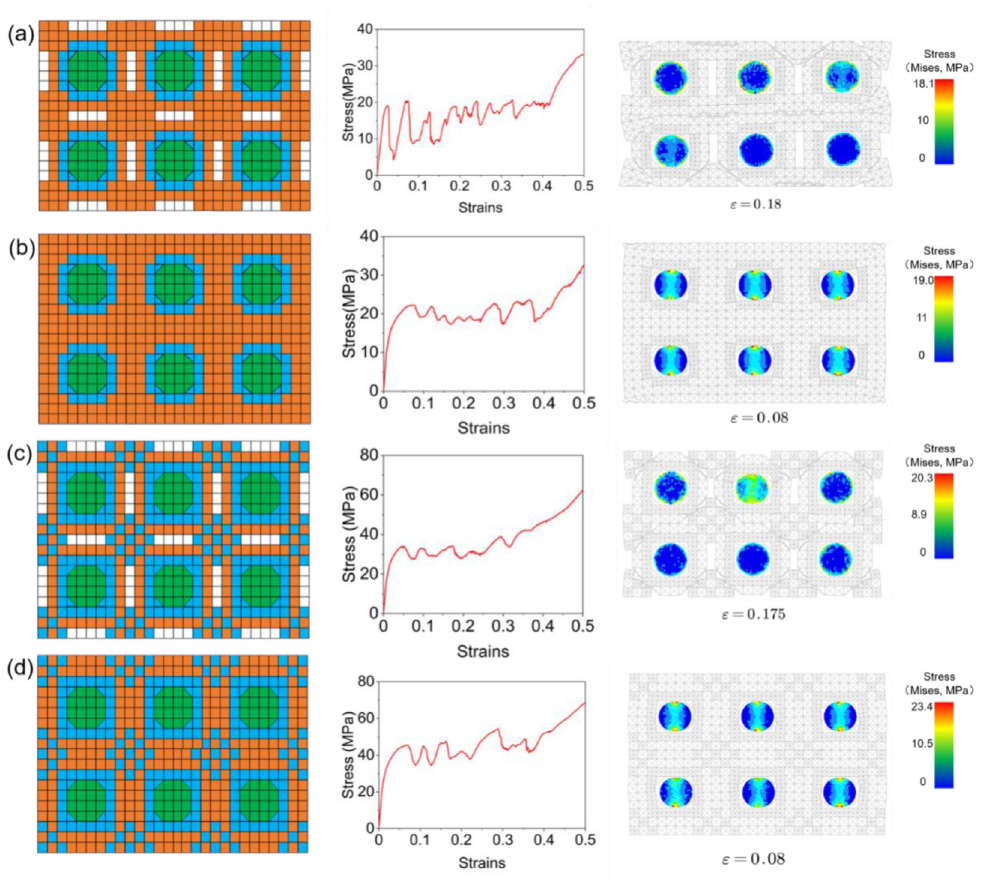
Fig. 4. Simulation of the multifunctional energy storage system with or without voids under compression. (a, b) Systems with Type-B RVE comparing those without voids. (c, d) Systems with Type-C RVE comparing with those without voids.